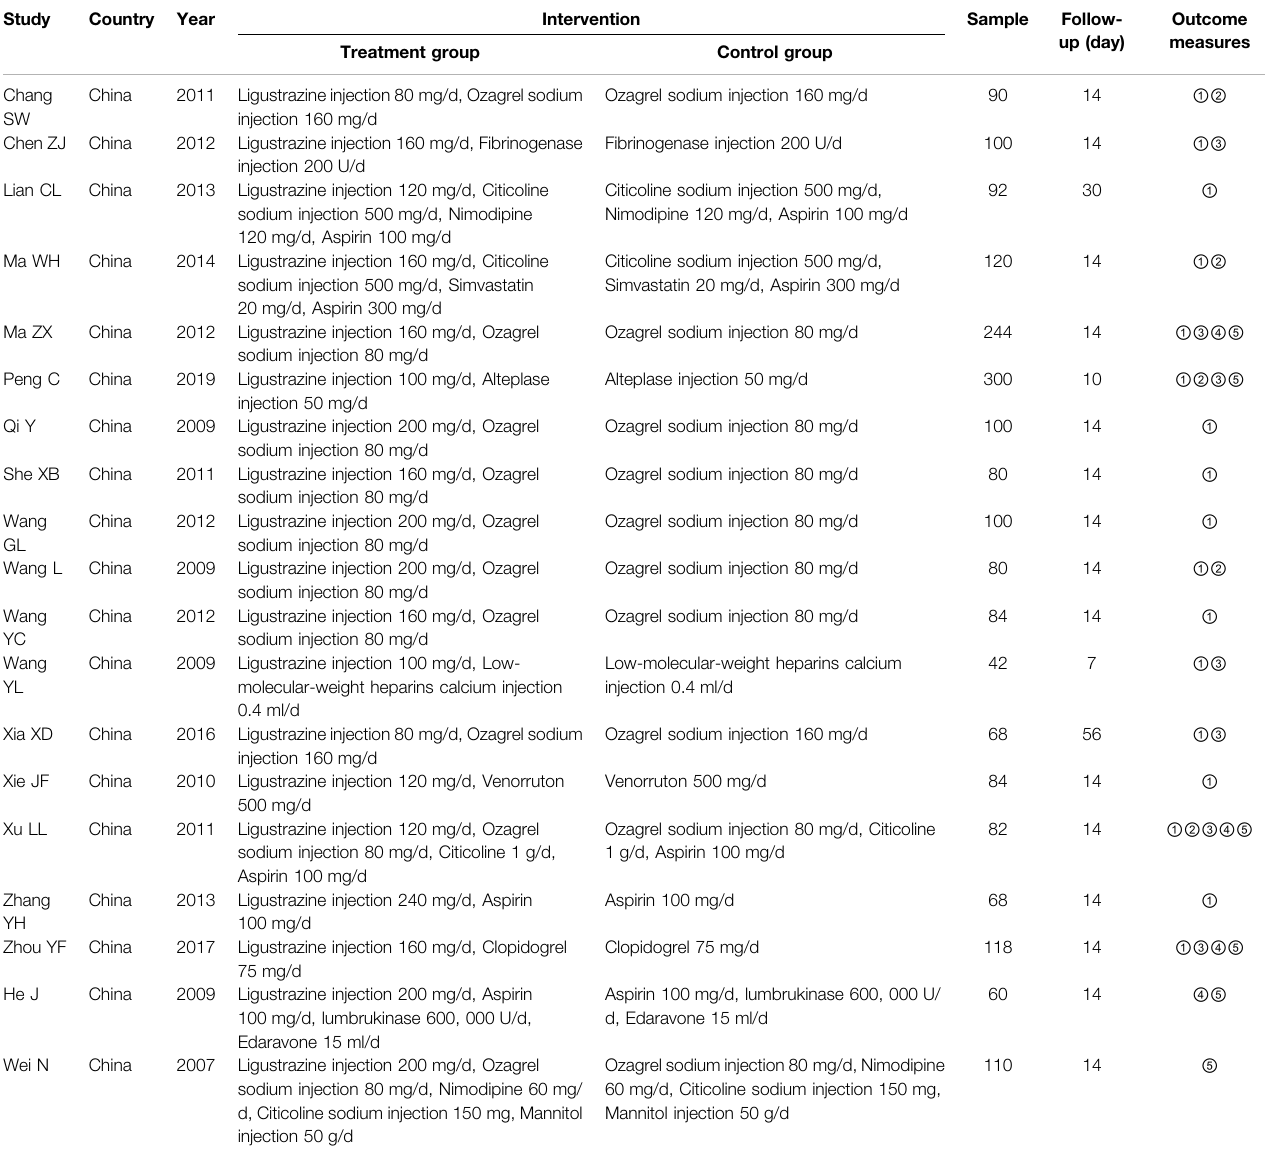
TABLE 1 | Characteristics of RCTs on ligustrazine injection for ACI. Study Country Year Intervention Sample Follow-